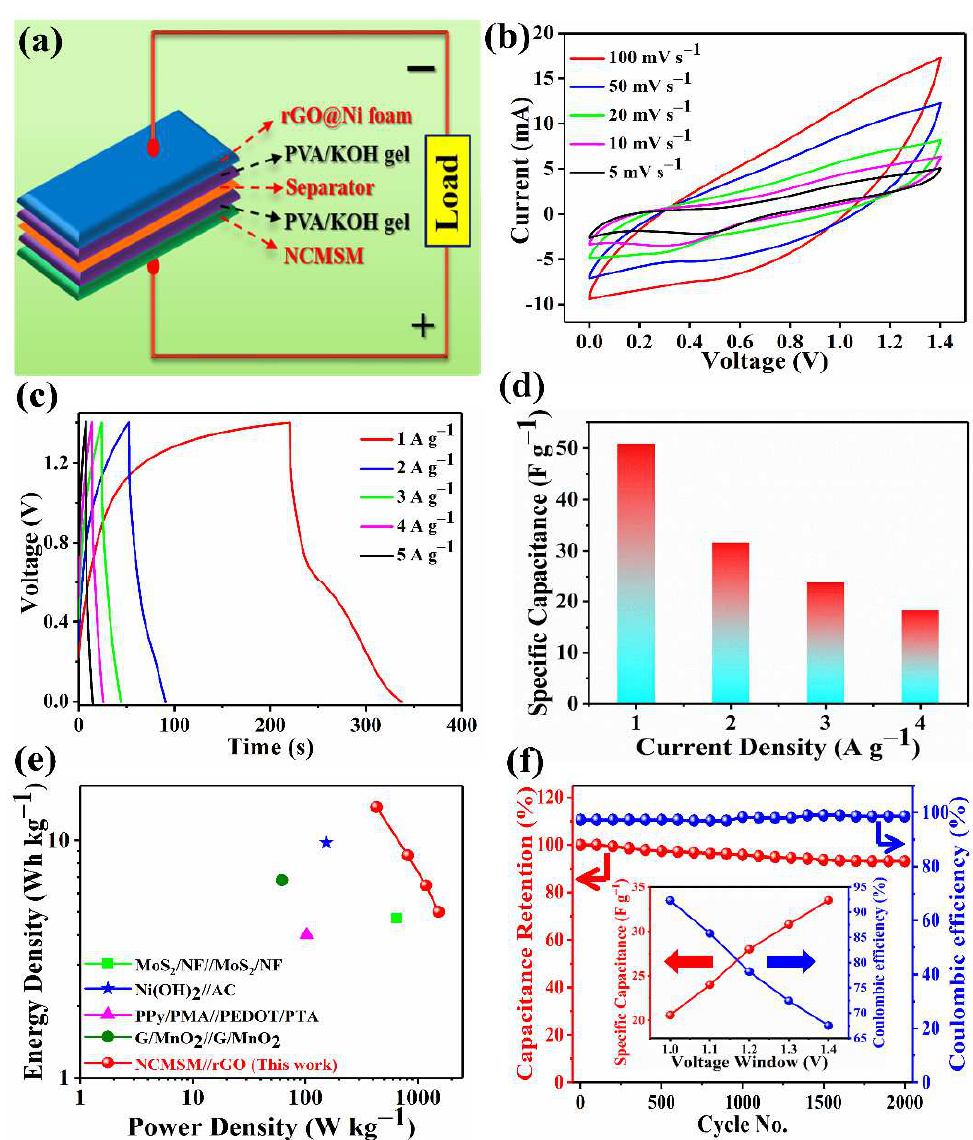
Figure 11. Electrochemical performance of a solid-state asymmetric SC (SASC, NCMSM//rGO): ( a ) schematic diagram of the device, ( b ) CV curves at various scan rates within a fixed potential window of 1.4 V, ( c ) galvanostatic charge-discharge curves at several current densities, ( d ) histogram of C s as a function of current density, ( e ) Ragone plot, and ( f ) cycling stability curve (measured at the current density of 5 A g − 1 ); the inset shows the specific capacitance of the device at different potential windows from 1 to 1.4 V.